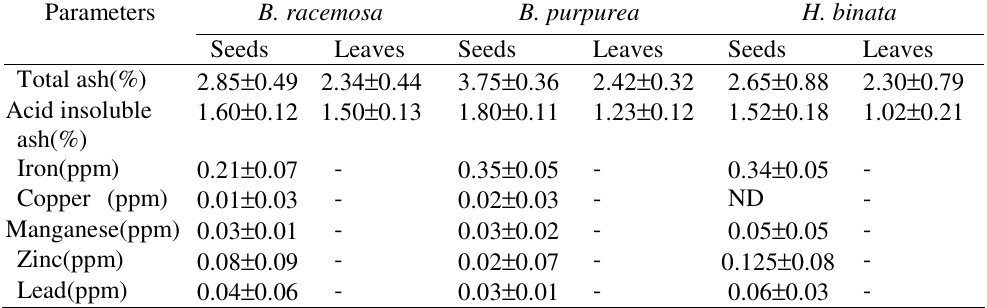
Table-2 . Data of the physico-chemical parameters Parameters